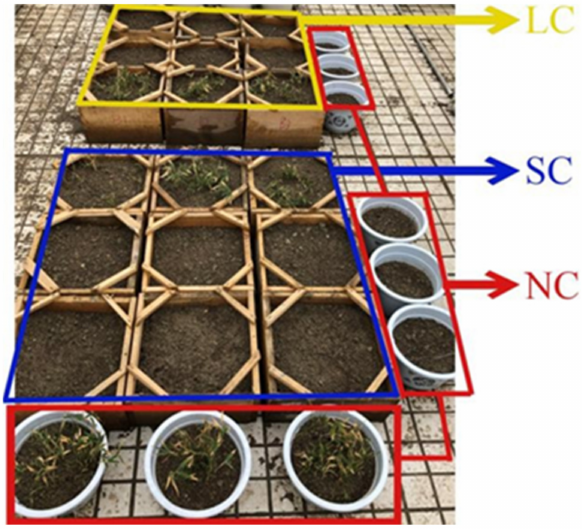
Figure 5. Locations of treatments.